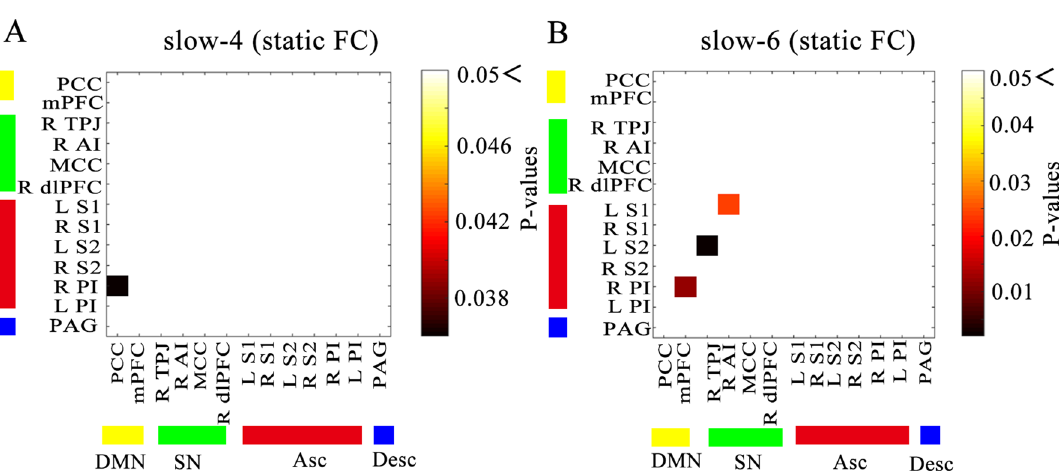
Figure 3. Static functional connectivity. Matrices indicate significant group differences in the slow-4 ( A ) and slow-6 ( B ) frequency bands. Two-sample t test, P < 0.05 with FDR